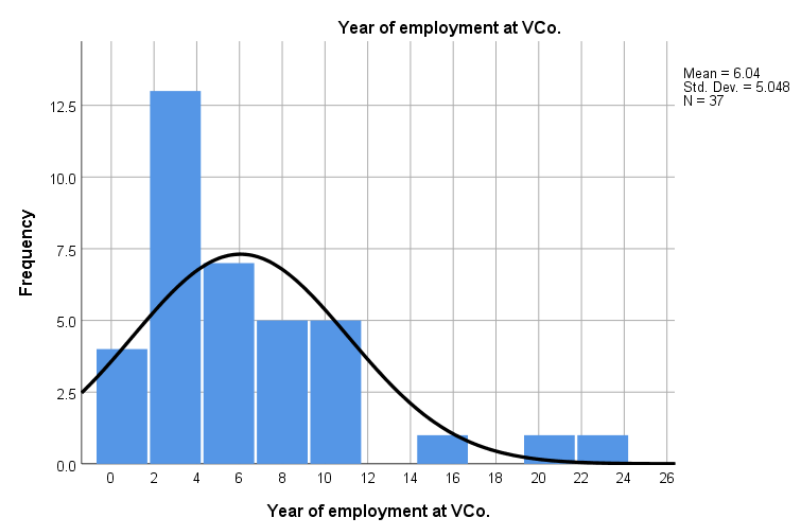
Figure A2. Distribution of Year of employment at VCo.